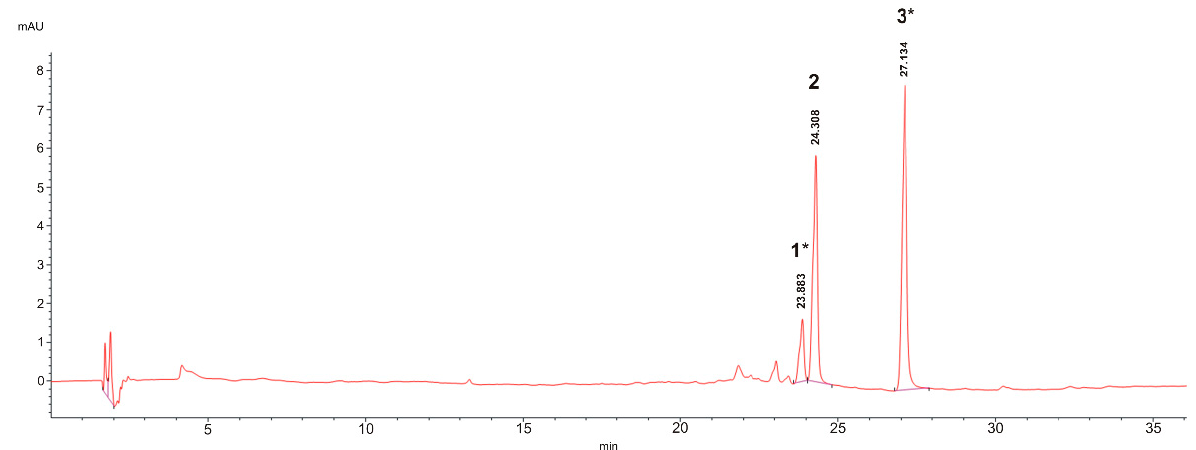
Figure 1. HPLC-DAD chromatogram of E. characias extract at λ = 360 nm. Chromatographic conditions are described in the text. 1: quercetin-3-O-arabinoside; 2: quercetin-3-O-rhamnoside; 3: quercetin-3-(2-O-acetyl)-arabinoside; * tentative attribution and amount expressed as quercetin-3- O-rhamnoside equivalents.